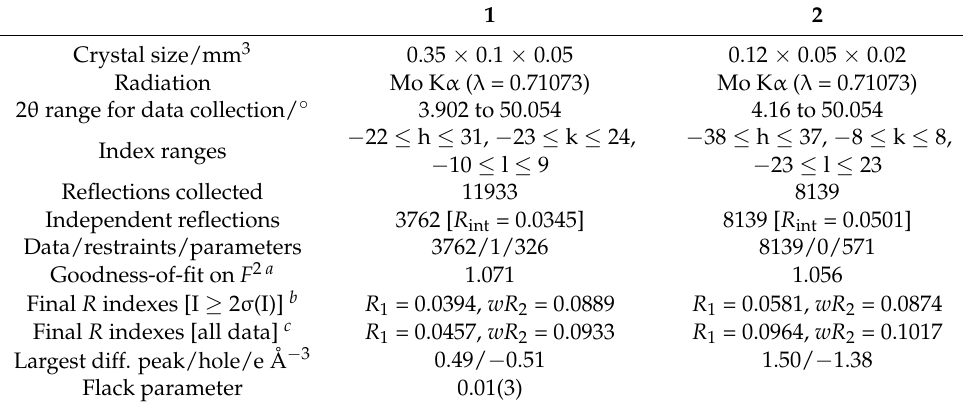
Table 2. Crystal data and structure refinement for 1 and 2